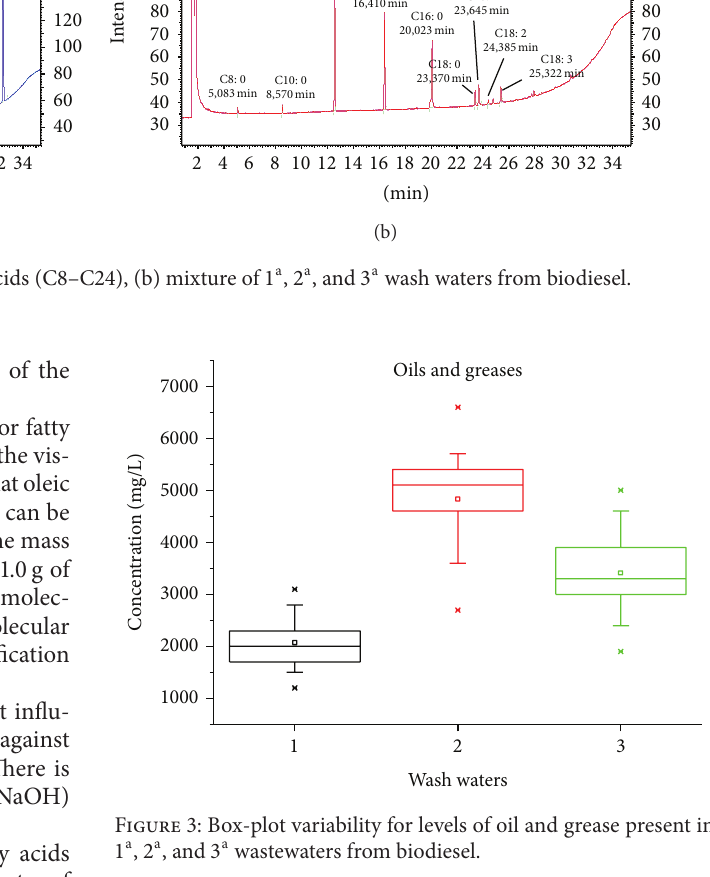
thus, they do not comply with federal regulations. These results show that despite the low solubility of oils and greases, they appear as wastewater generated in the purification of position process the presence of oils and greases reduces the dissolved oxygen raising the biochemical oxygen demand (BOD) and chemical oxygen demand (COD), changing the aquatic